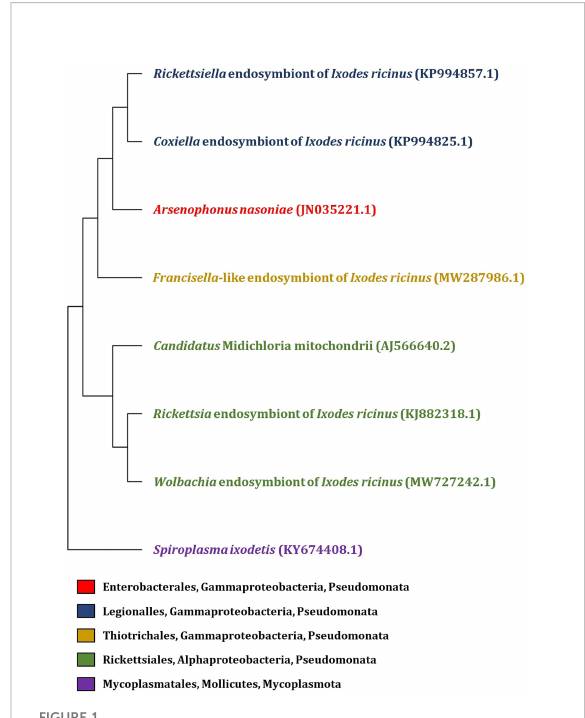
FIGURE 1 Phylogenetic tree of endosymbiotic bacteria based on 16S rRNA gene identi fi ed in I. ricinus . The phylogenetic tree was constructed by MEGA 11 program, with partial 16S rRNA gene sequence of endosymbionts isolated from the tick I. ricinus (the GenBank accession numbers are listed in the fi gure). Sequences were aligned using Muscle (Multiple Sequence Alignement) and the tree was constructed by Neighbor-joining method with Maximum Composite Likelyhood